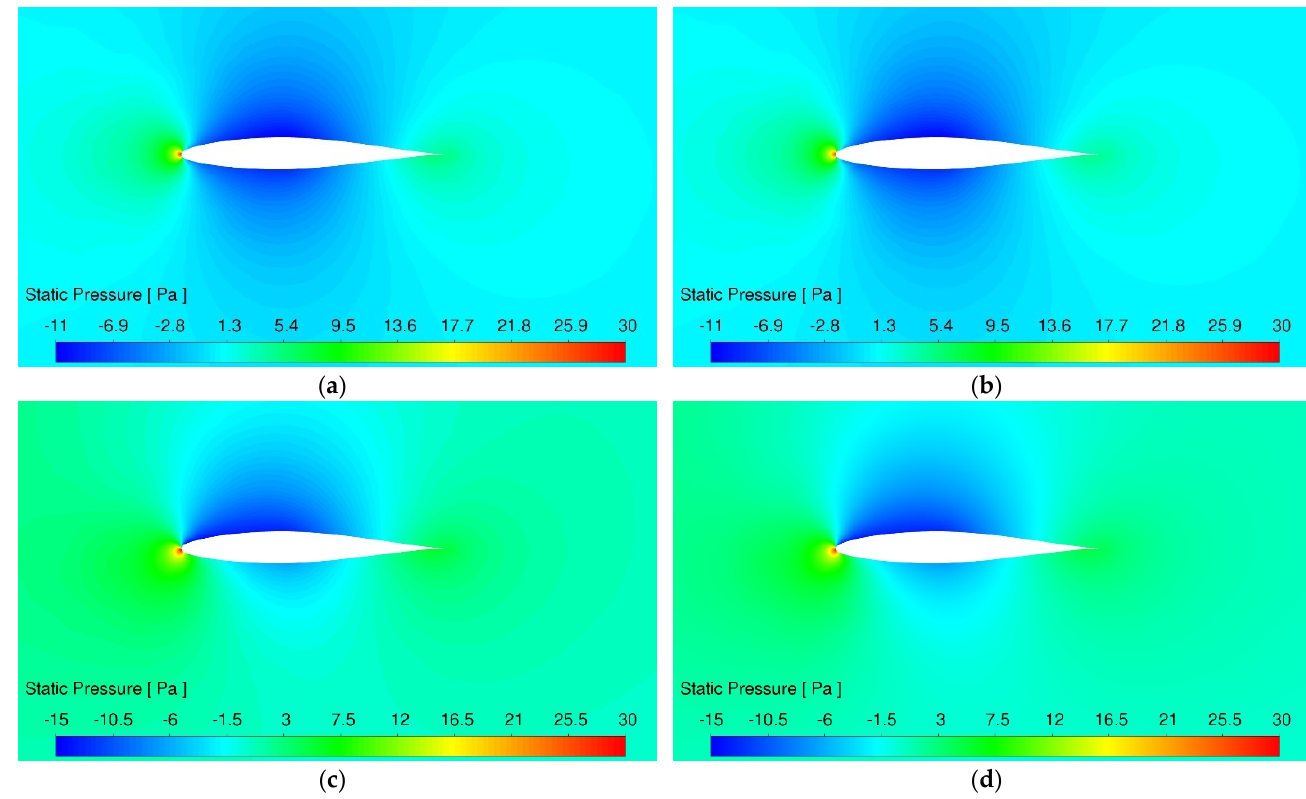
Figure 15. Contours of static pressure over the original model at angle of attack ( a ) 0° in one-phase flow, ( b ) 0° in two-phase flow, ( c ) 16° in one-phase flow, and ( d ) 16° in two-phase flow.